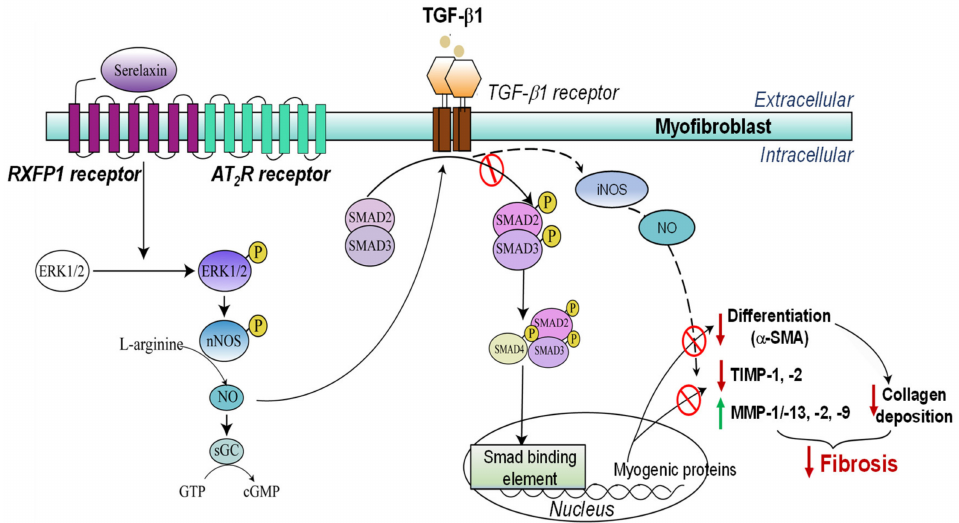
Figure 5. The signal transduction mechanisms underlying the anti-fibrotic effects of RLX in myofibrob- lasts. Upon binding to RXFP1 on myofibroblasts and remodelling through RXFP1 and RXFP1-AT 2 R crosstalk (when both receptors are adequately expressed), RLX inhibits the TGF- β 1/Smad2 axis and the ability of Smad2 to interact with pro-fibrotic Smad3 and Smad4; this is required for the TGF- β 1-induced promotion of myofibroblast differentiation and ECM production. As TGF- β 1 promotes TIMP activity and inhibits MMP activity, the RLX-induced suppression of TGF- β 1 ameliorates the TGF- β 1-induced upregulation of TIMP-1 and -2 and promotes the expression and activity of various collagen-degrading MMPs (MMP-1/-13, -2, -9) from myofibroblasts. Figure adapted from